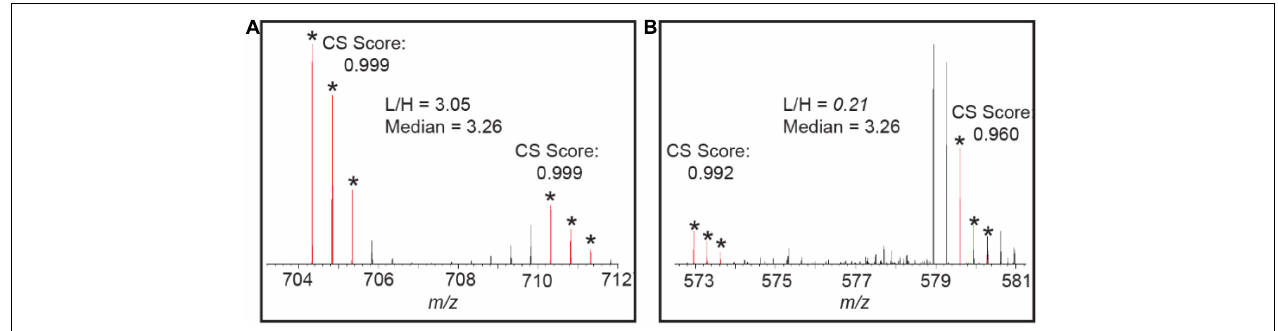
FIGURE 6 | (A) Good CS scores are reported for the 14 N and 15 N peptide pair of “LTYYTPEYETK” from the protein RIBULOSE-BISPHOSPHATE CARBOXYLASE (RBCL) in MS 1 and the L/H ratio of this peptide is close to the median ratio. (B) The L/H ratio of the peptide “DLAVEGNEIIREACK” from RBCL shows outlier quantification measurement and a poor CS score is reported for 15 N labeled peptide in this